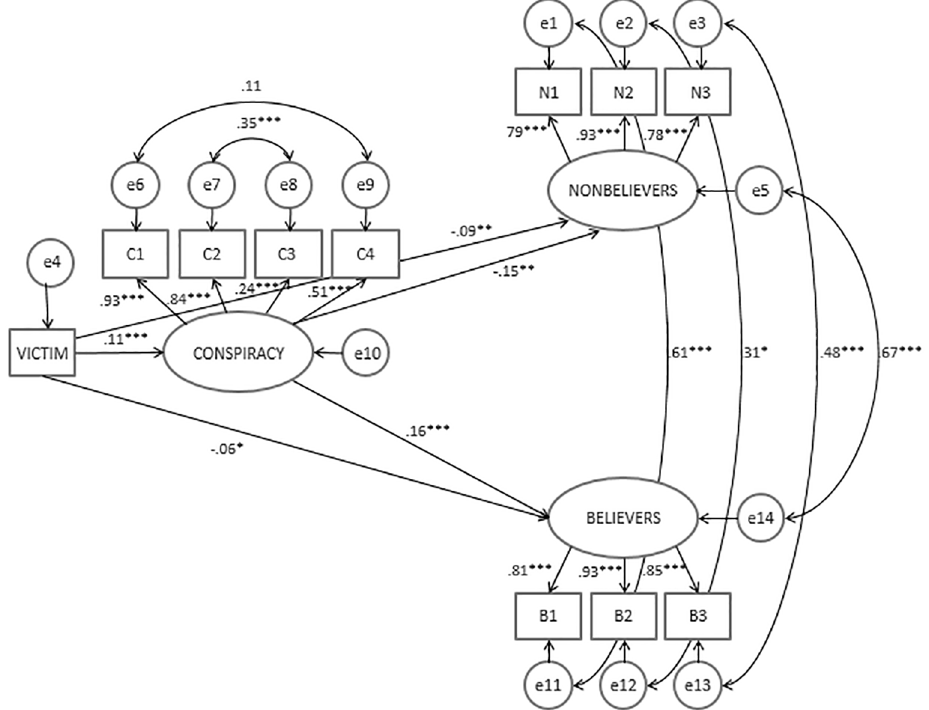
Figure 1. Structural equation model: Indirect effects of unique in-group suffering beliefs on distance towards Smoleńsk conspiracy believers and non-believers through the endorsement of conspiracy beliefs of the air crash. Standardized regression